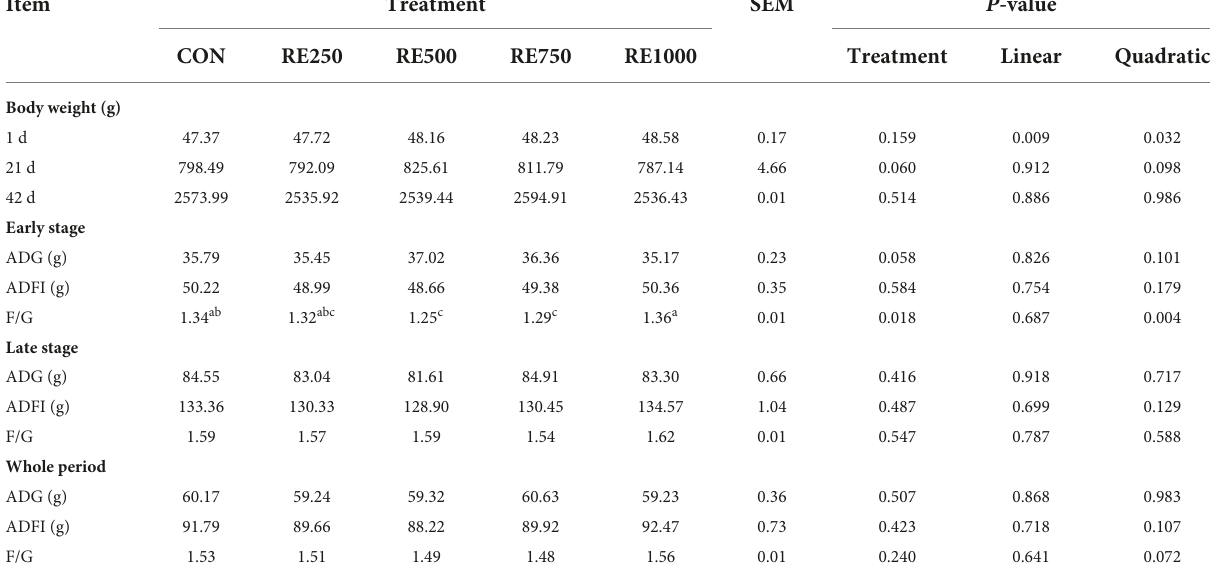
TABLE 2 Effects of rosemary extract on the growth performance of broilers 1 .